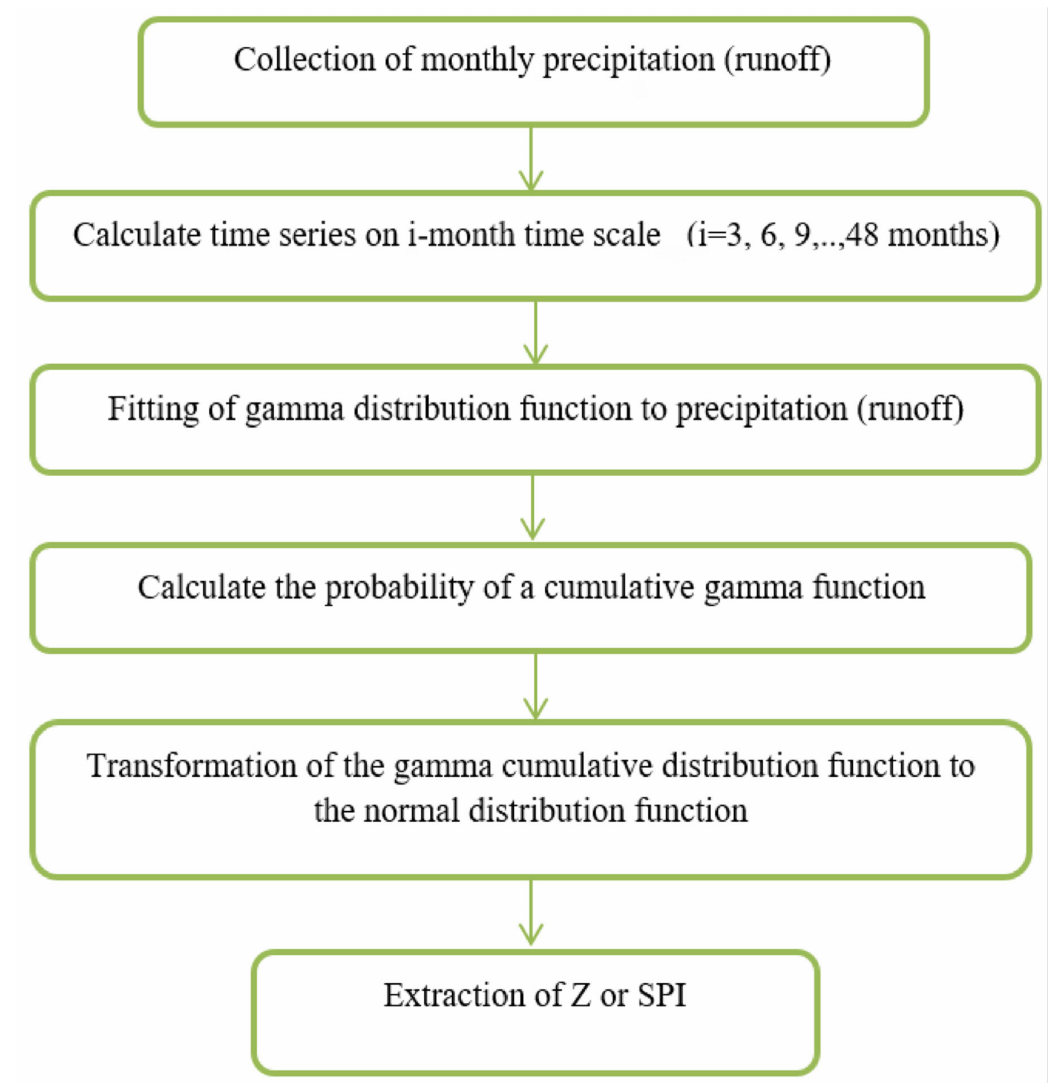
Figure 2. Methodology of SPI and